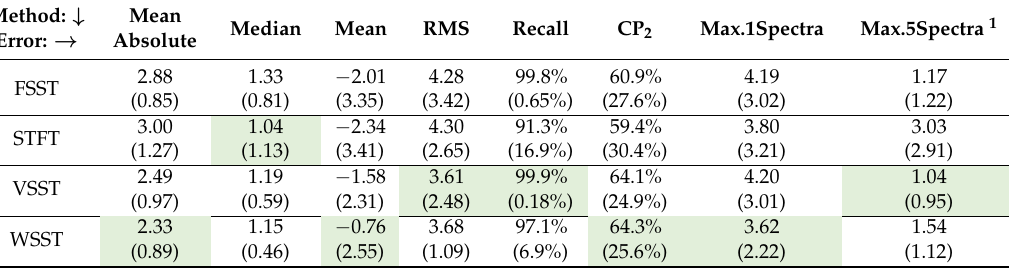
Table 1. Mean, mean absolute, median absolute errors, and the root-mean square errors of the studied methods in breaths per minute. CP 2 represents the percentage of results falling within 2 bpm margin when compared with RR reference. Max.1Spectra represents results if RR was estimated by taking greatest magnitude component of the spectra, Max.5Spectra if out of 5 greatest components, one closest to reference would be chosen. Standard deviations of each value between subjects have been given in parenthesis. The result produced by best performing method in each metrics is shown with green background.